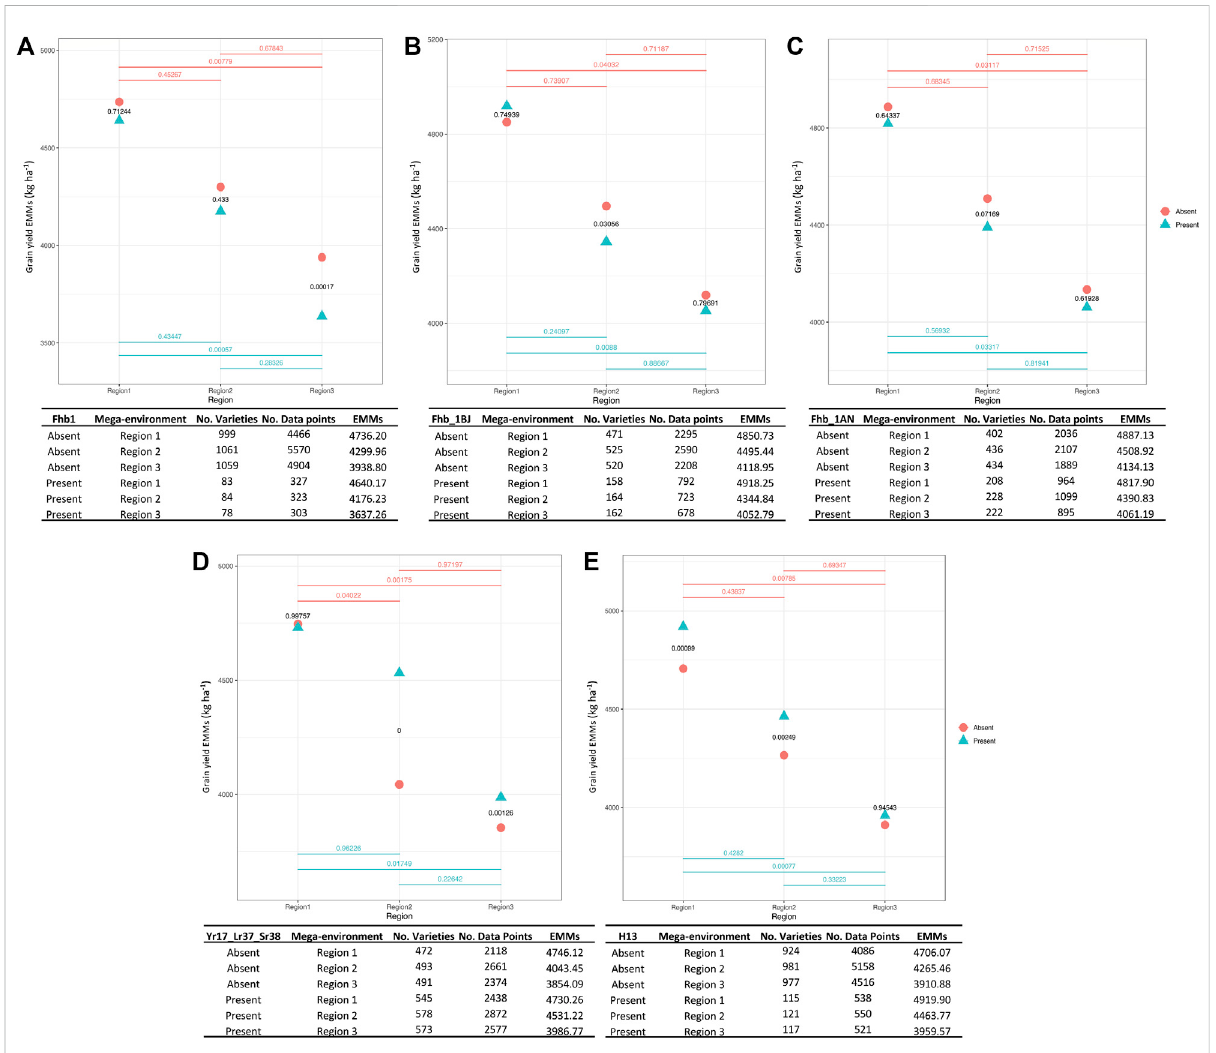
FIGURE 4 QTL-by-environment plots for YLD when fi ve major genes are present or absent within three major testing regions (target population of environments or mega-environments). Fusarium head blight (FHB) ( F. graminearum ) resistance genes, Fhb1 (A) , Fhb_1B derived from ‘ Jamestown